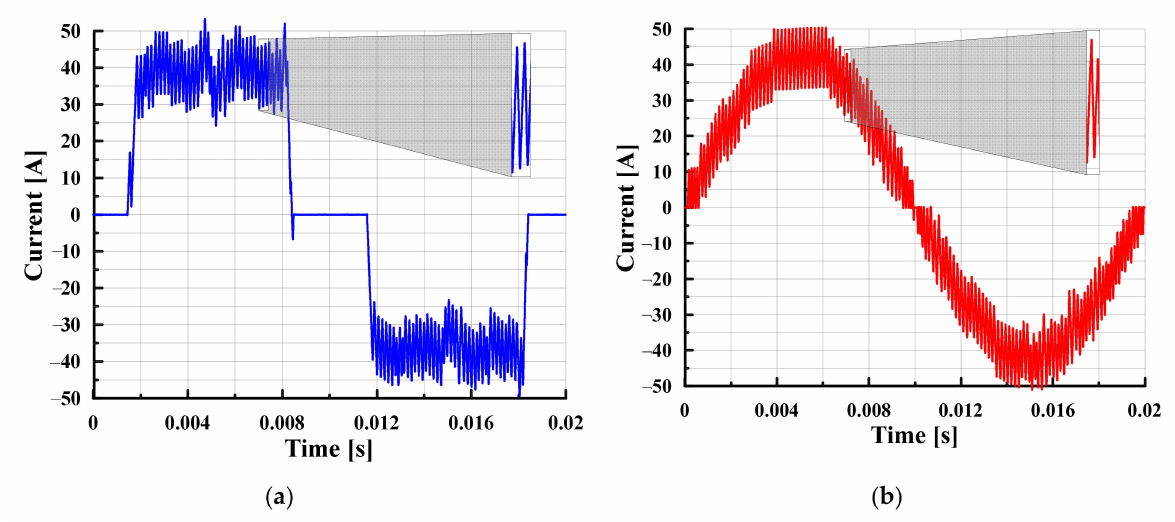
Figure 7. ( a ) One period of BLDC current; ( b ) one period of BLAC